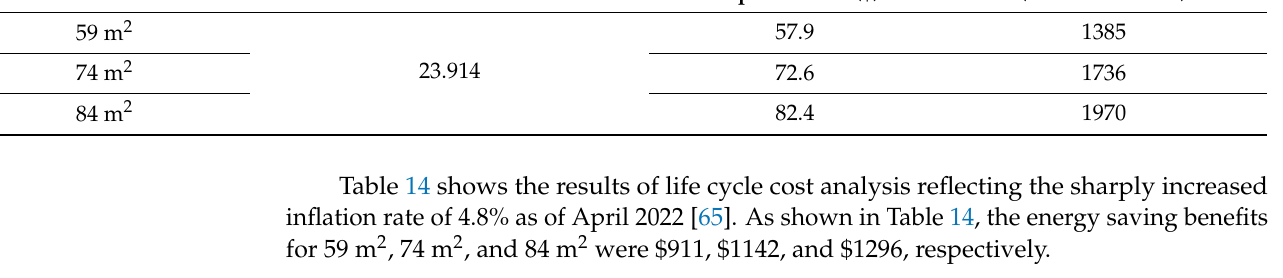
Table 11. Energy cost of district heating energy and electricity for the M complex before and after Table 14. Reflecting the inflation rate of 4.8% as of April 2022, life cycle cost analysis using annuity present value factor for 30 years. (Currency: 1$ improvement. (Currency: 1$ ≒ 1200 KRW, as of 7 January